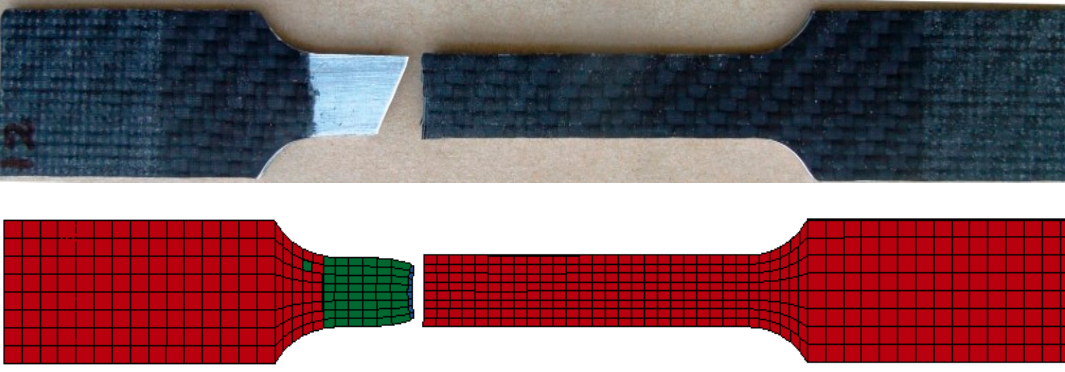
Figure 30. FEA and experimental failed specimen of CARALL-B with no veil cloth.